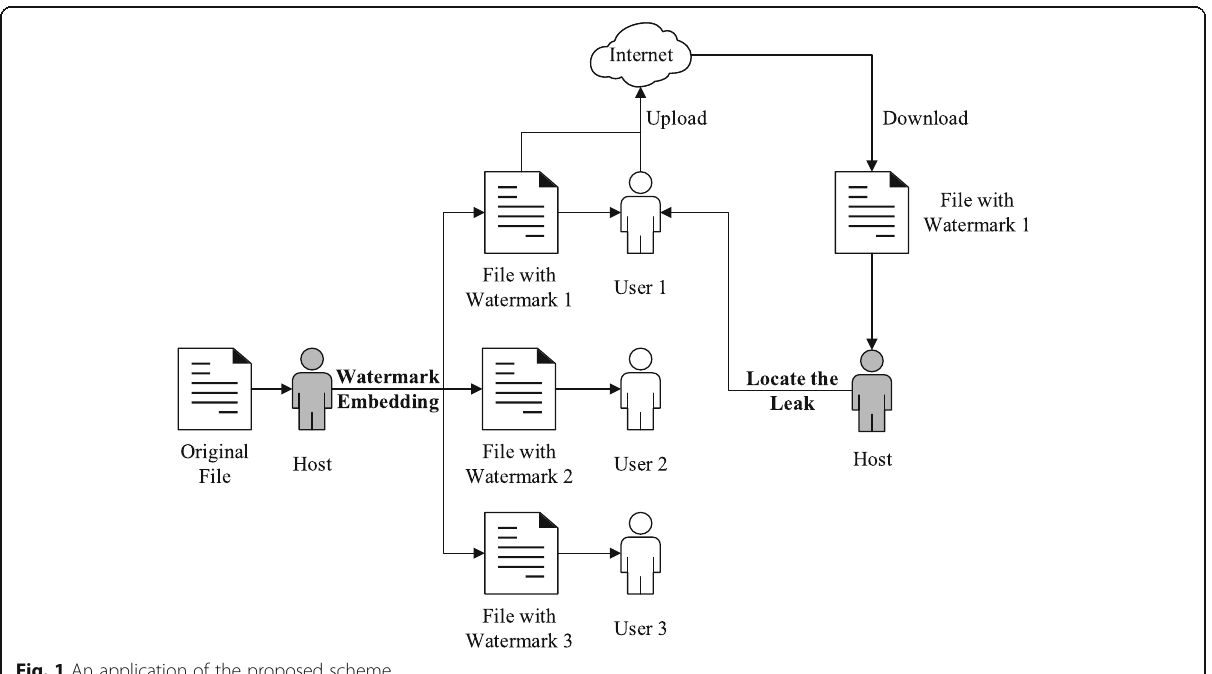
Fig. 1 An application of the proposed